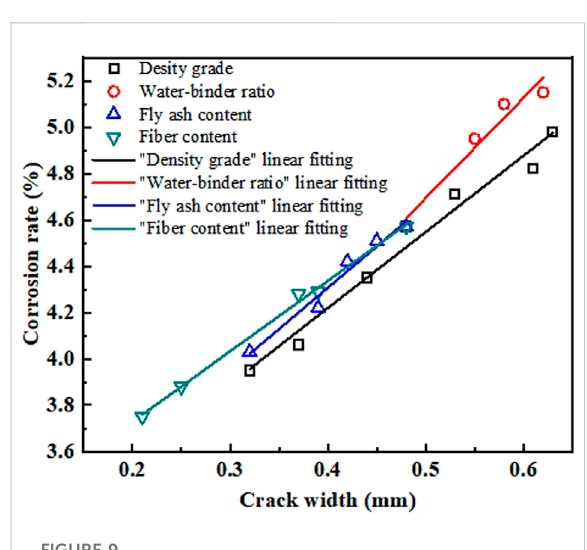
FIGURE 9 Fitted relationship between crack width and corrosion rate.